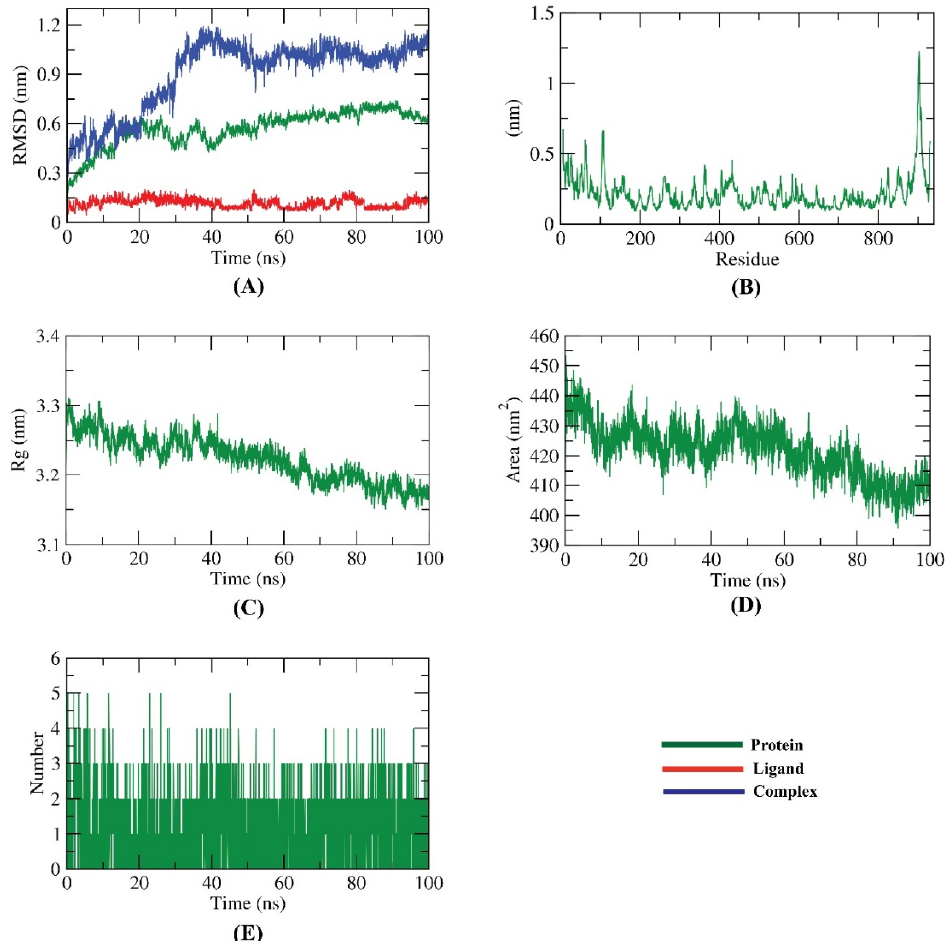
Figure 9. Molecular dynamics simulation results: ( A ) RMSD values, ( B ) RMSF, ( C ) R g , ( D ) SASA, ( E ) H-bonding of the RdRp-K3G-A complex.